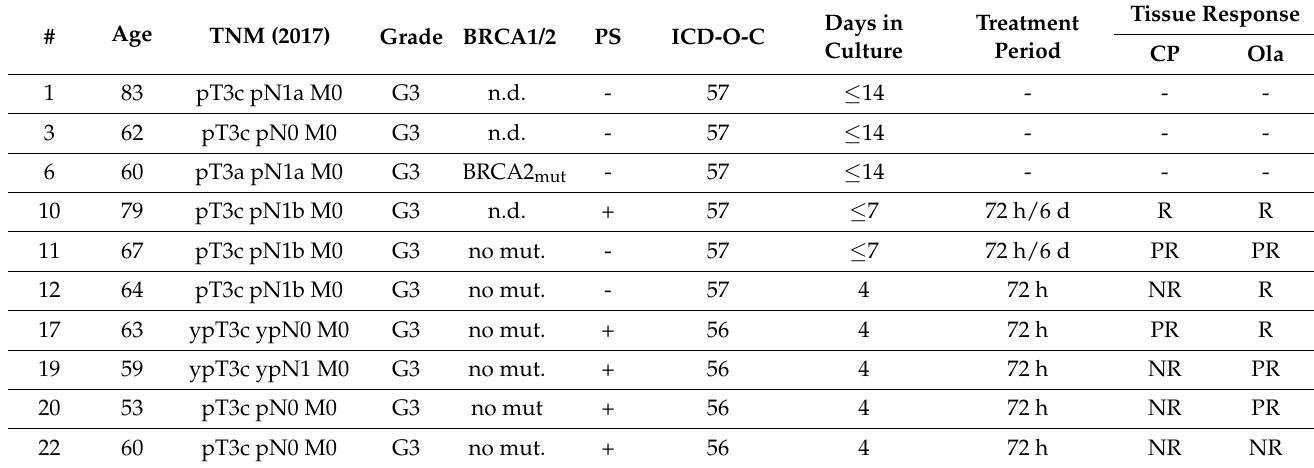
Table 1. Patient data and experimental tissue